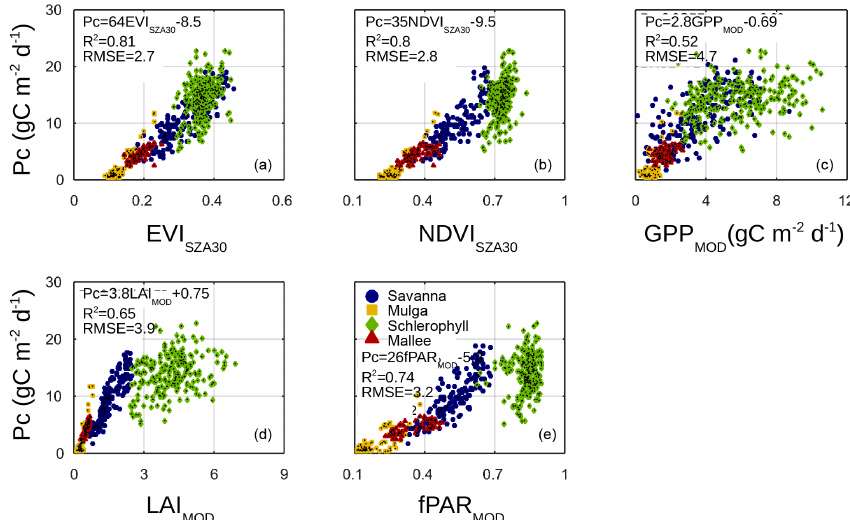
Figure 8. Relationships between 16-day mean values of photosynthetic capacity (Pc; gCm − 2 d − 1 ) and different RS products: (a) MODIS fixed solar zenith angle of 30 ◦ enhanced vegetation index (EVI SZA30 ) , (b) normalized difference vegetation index (NDVI SZA30 ) , (c) MODIS gross primary productivity (GPP MOD ; gCm − 2 d − 1 ) , (d) leaf area index (LAI MOD ) , and (e) fraction of the absorbed photosynthetic active radiation (fPAR MOD ) . Four key Australian ecosystem sites are included in the analysis: AU-How savanna (blue circles), AU-ASM mulga (yellow square markers), AU-Cpr mallee (red triangles), and wet sclerophyll forest of AU-Tum (green diamonds).